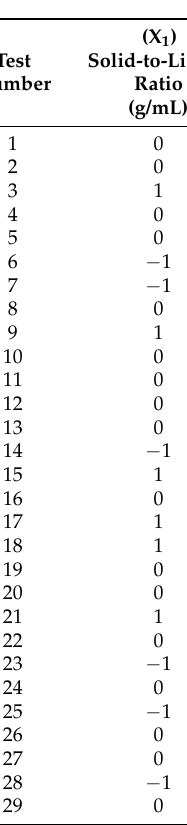
Table 1. Response surface test